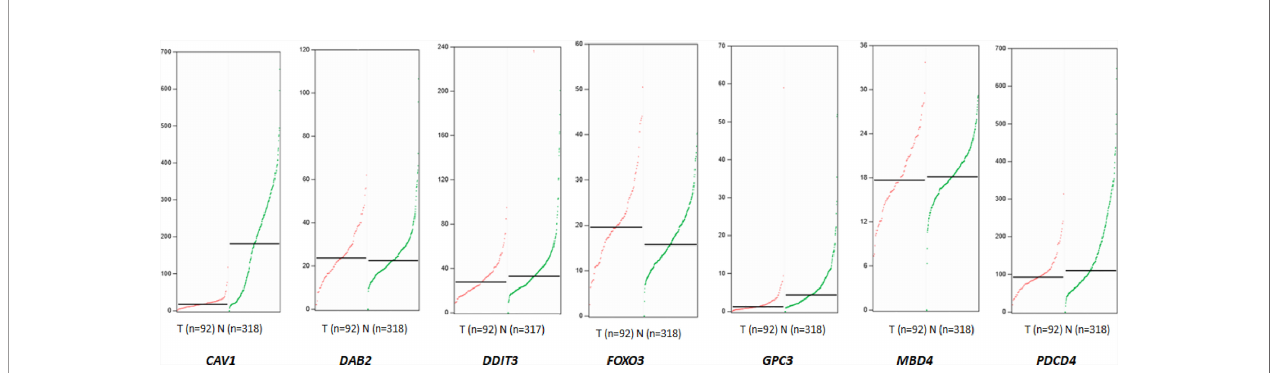
FIGURE 6 | The expression pro fi les of seven target genes that may be regulated by miRNA-96-5p obtained from the GEPIA website in rectal cancer tissues and normal tissues. The median values of CAV1, DAB2, DDIT3, FOXO3, GPC3, MBD4 and PDCD4 in rectal cancer tissues and normal tissues were 17.16 and 180.87, 23.78 and 22.54, 27.78 and 33.00, 19.58 and 15.76, 1.24 and 4.3, 17.76 and 18.13, 92.51 vs.110.35, respectively. The red line represents the tumor, and the green line represents